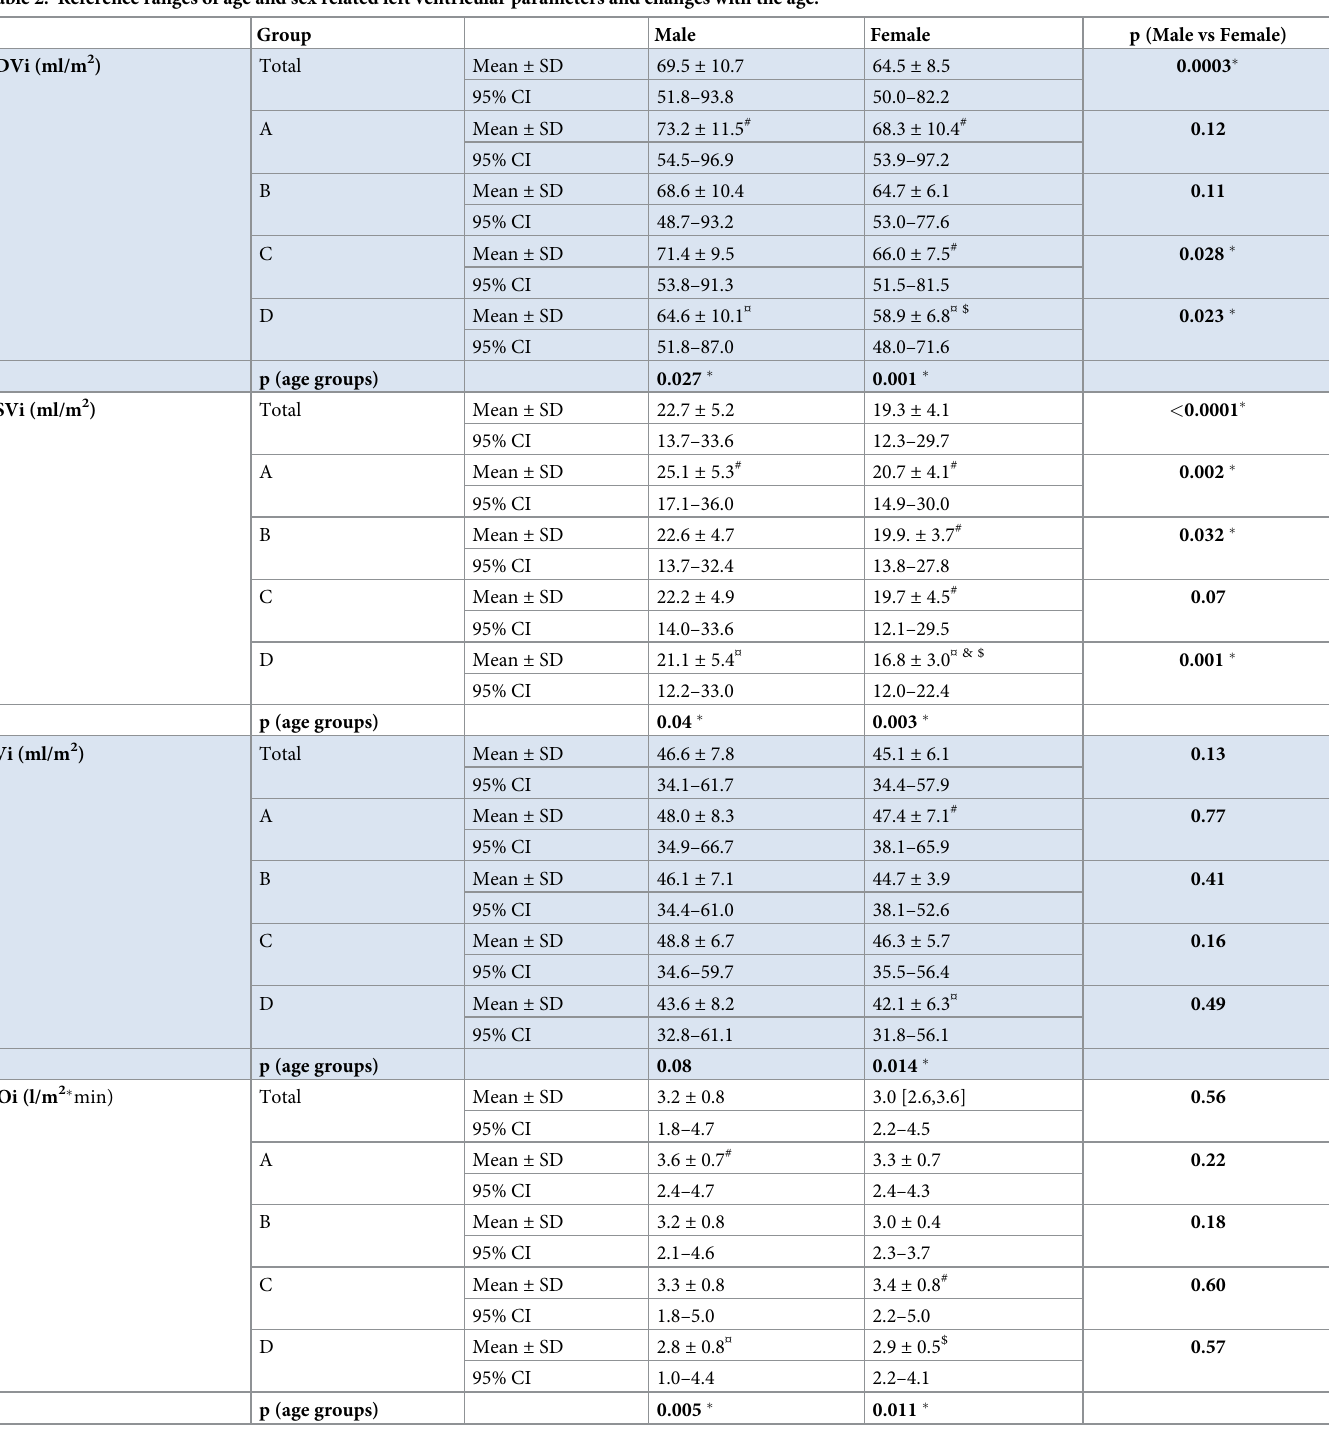
Table 2. Reference ranges of age and sex related left ventricular parameters and changes with the